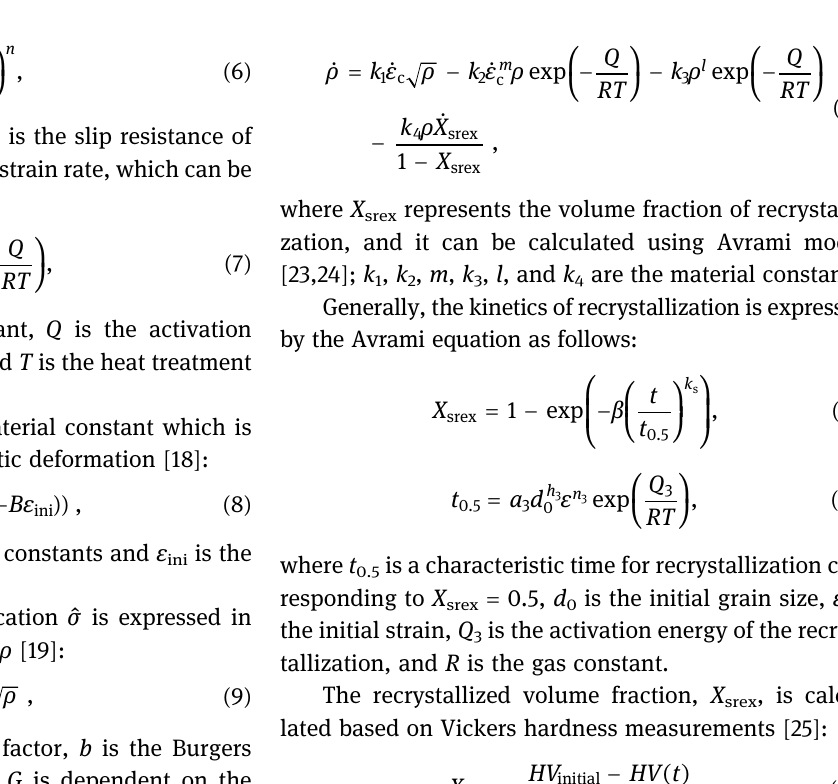
Figure 4: ( a ) Cold - forging process; dimensions of ( b ) cold - forged semi - spherical shell; and ( c ) fi nal part machined